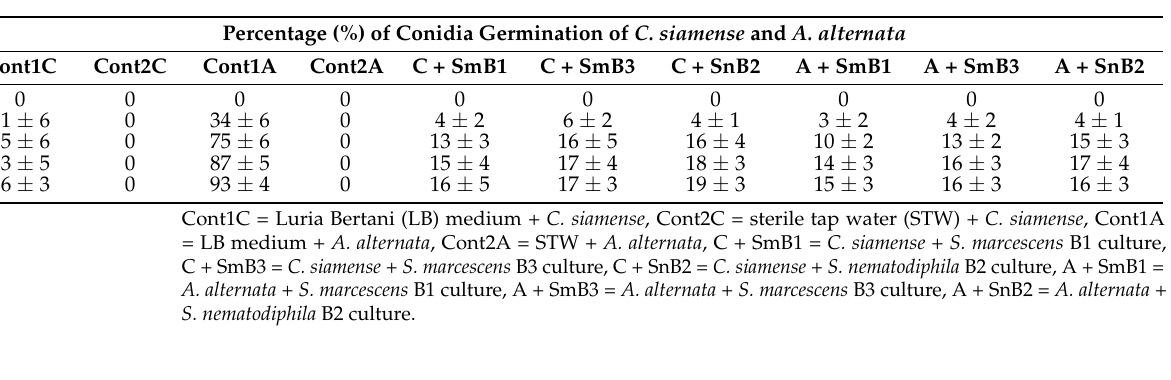
Figure 2. Antifungal effect of 3 bacterial strains against A. alternata in culture medium.